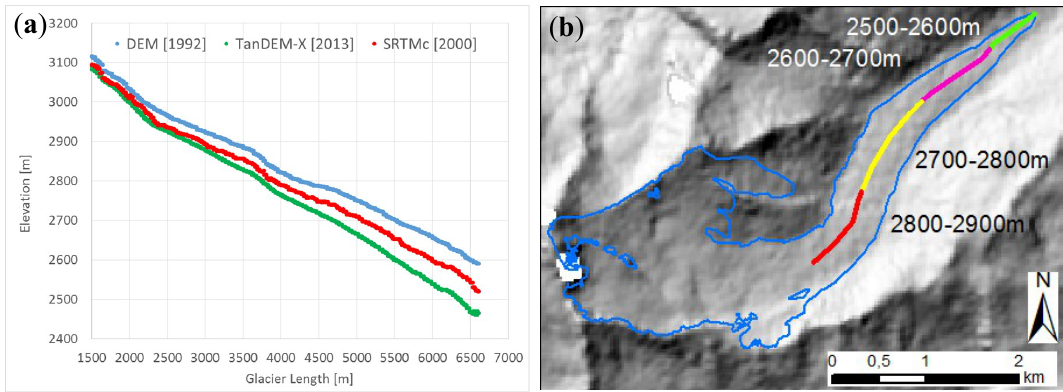
Table 5. Mean elevation differences for the listed elevation intervals for HEF from the DEM 1992, the SRTM DEM (2000) and the TanDEM-X DEM (2013).